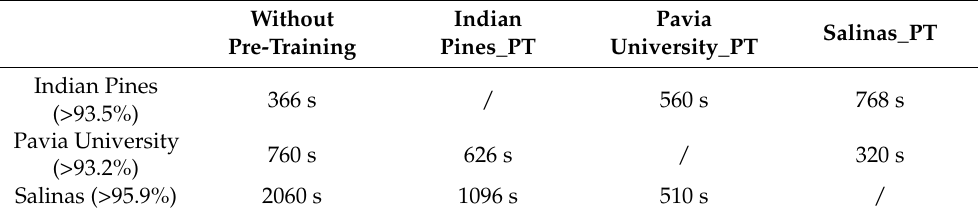
Table 7. Effect of transfer learning on training efficiency for three